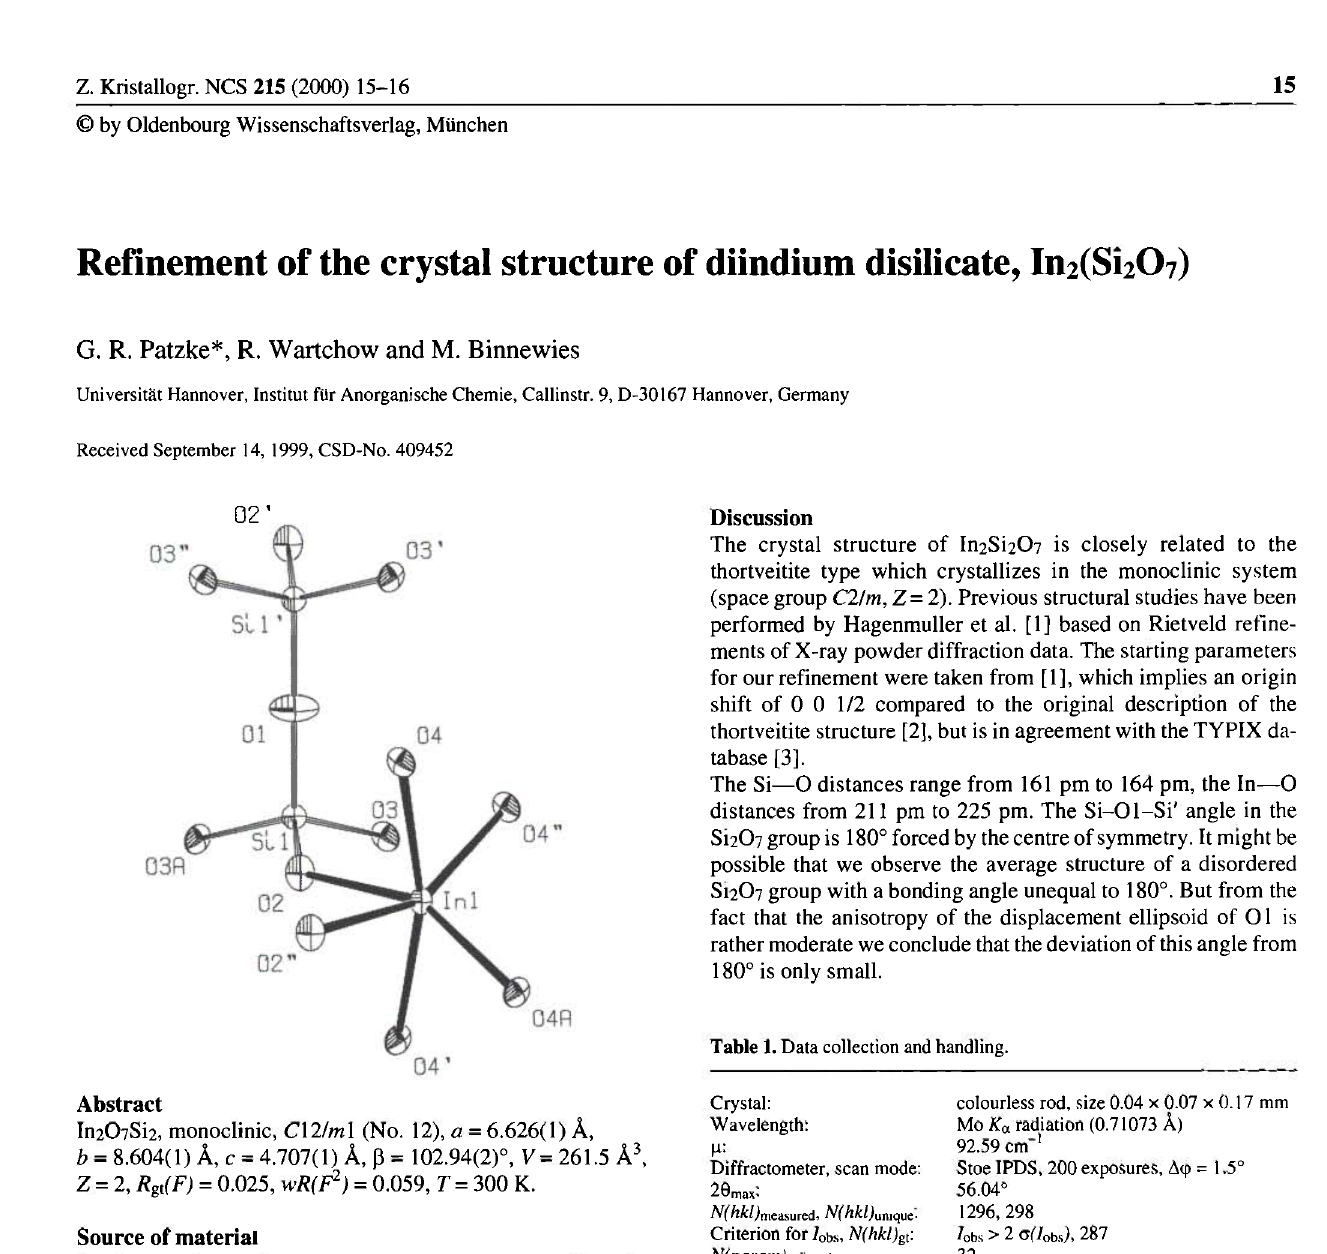
Table 1. Data collection and handling.